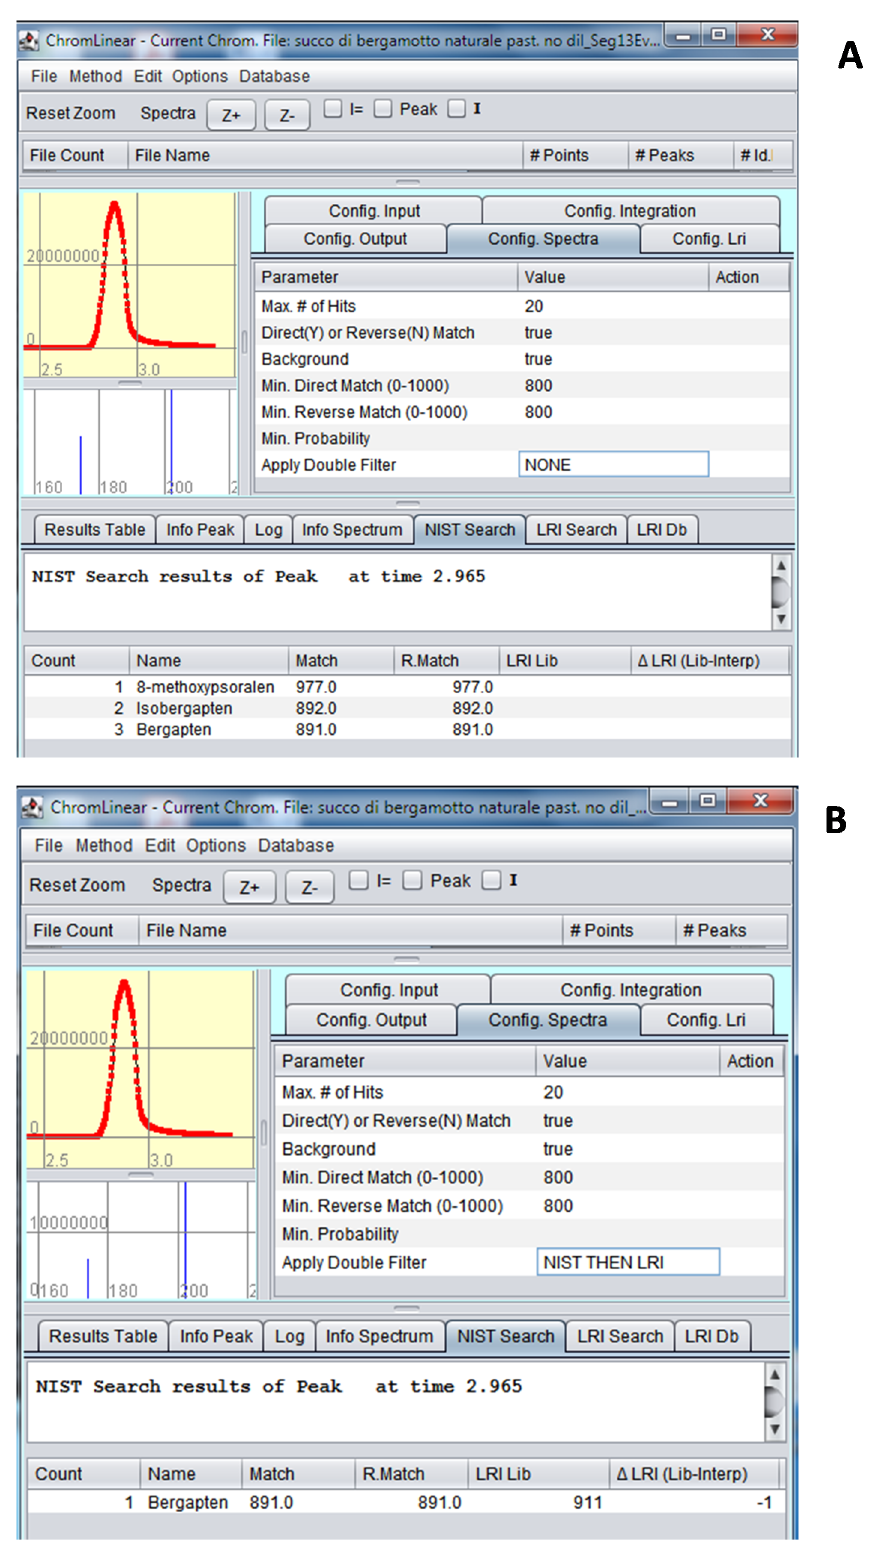
Figure 3. ( A ) Spectral similarity search results and ( B ) dual-filter search results for peak 3 (bergapten). Three different commercial bergamot alcoholic beverages were analysed in this